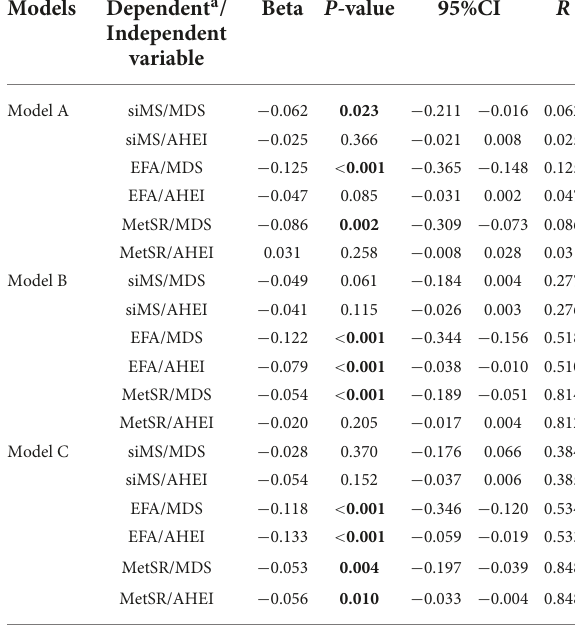
TABLE 6 Association of MetS scores with MDS and AHEI, as calculated by linear regression (beta non-standardized, 95% CI, P -value*, and strength of linear association R).